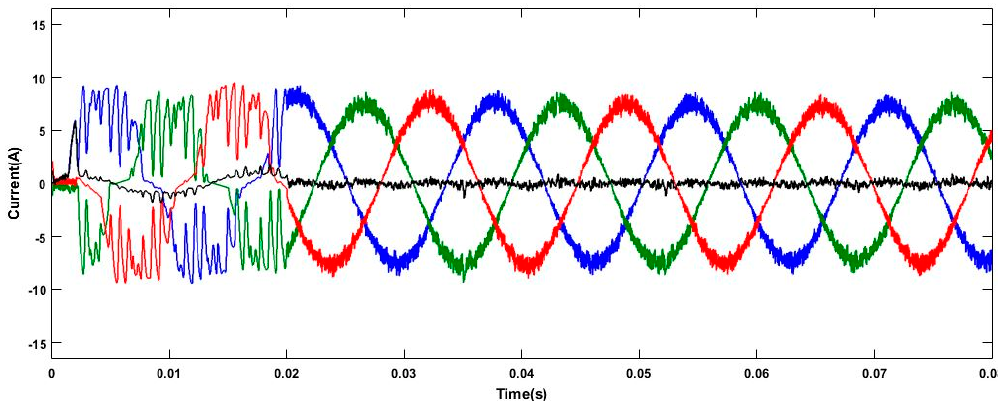
Figure 11. Compensation result with the traditional p-q method for case 2.